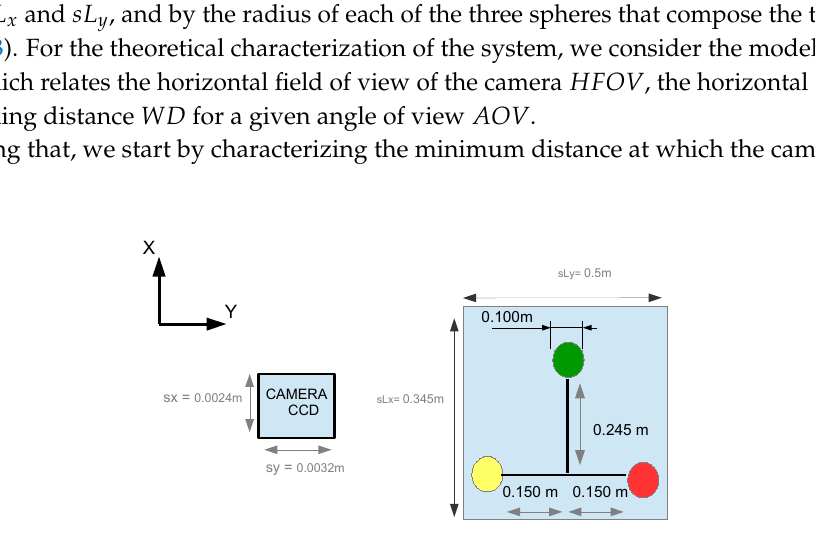
Figure 13. Image sensor size and Target dimensions in xy.